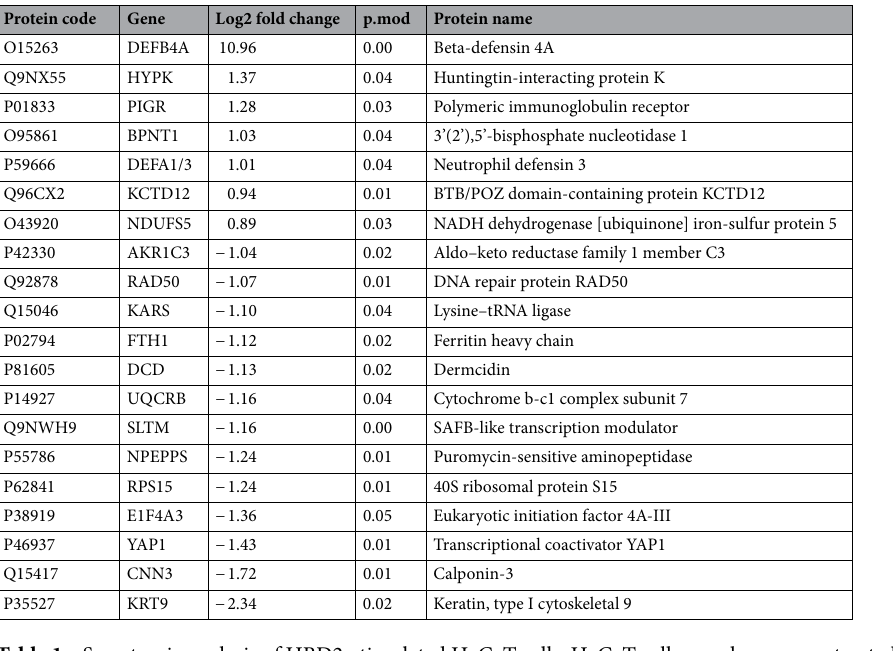
Table 1. Secretomic analysis of HBD2-stimulated HaCaT cells. HaCaT cell monolayers were treated with 0.5 μg/ml HBD2, or vehicle control, in serum free media for 48 h before supernatants were collected, centrifuged at 3000 rpm for 5 min, and stored at -80 °C prior to analysis; n = 5 per condition. Log fold changes and p values were generated using LIMMA pathway 43 . Table shows proteins with the greatest differences in detection levels between control and HBD2 treated conditions, listed by fold change, largest to smallest, with Uniprot protein code, gene code, fold change, p.mod value, protein name and brief description of function. Protein descriptions made using UniProt database information 46